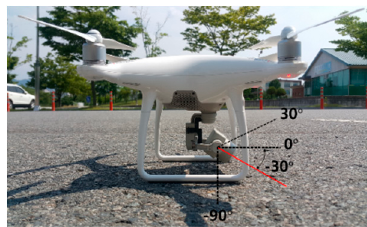
Figure 4. Drone with an attached camera.